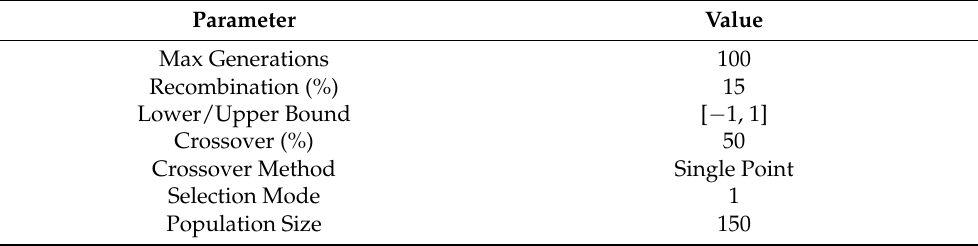
Table 8. Characteristics of the genetic algorithm combined with an ANN (GA-ANN).